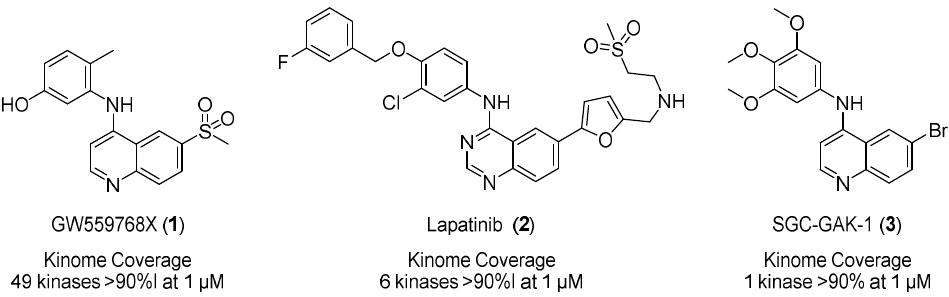
Figure 1. Previously reported 4-anilino-quin(az)olines ( 1 – 3 ) kinase inhibitors.